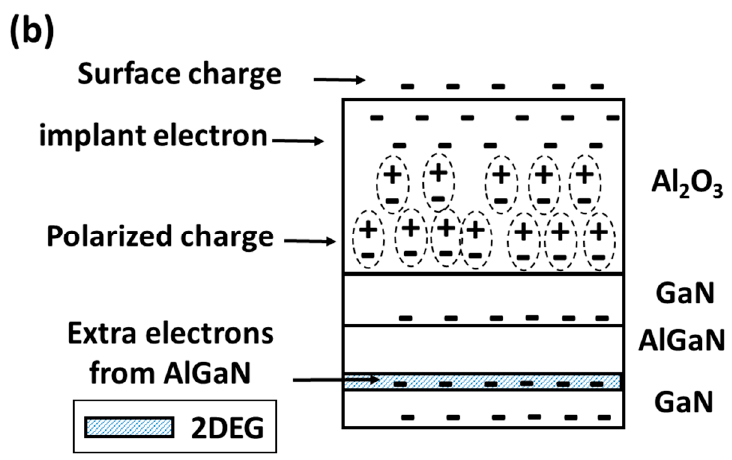
Figure 6. Mechanism of CDP treatment (CDPT) on ( a ) GaN and ( b ) Al 2 O 3 layers.